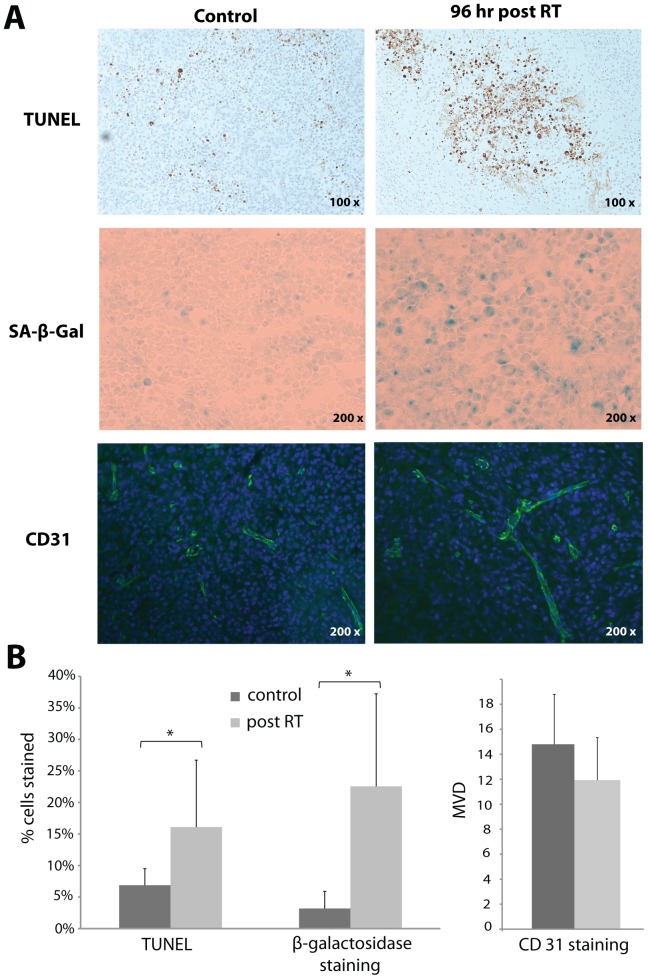
Apoptosis, senescence and vascularity of the tumors were assessed by TUNEL, SA-β-galactosidase and CD31 staining, respectively.A) Representative photographs of TUNEL, β-galactosidase and CD31 staining of control or radiation treated MDA-MB-231 tumors. B) Significantly increased cell apoptosis and senescence were observed for tumors treated with radiation (* p<0.05). Lower MVD was observed for the treated tumors but the difference was not significant.